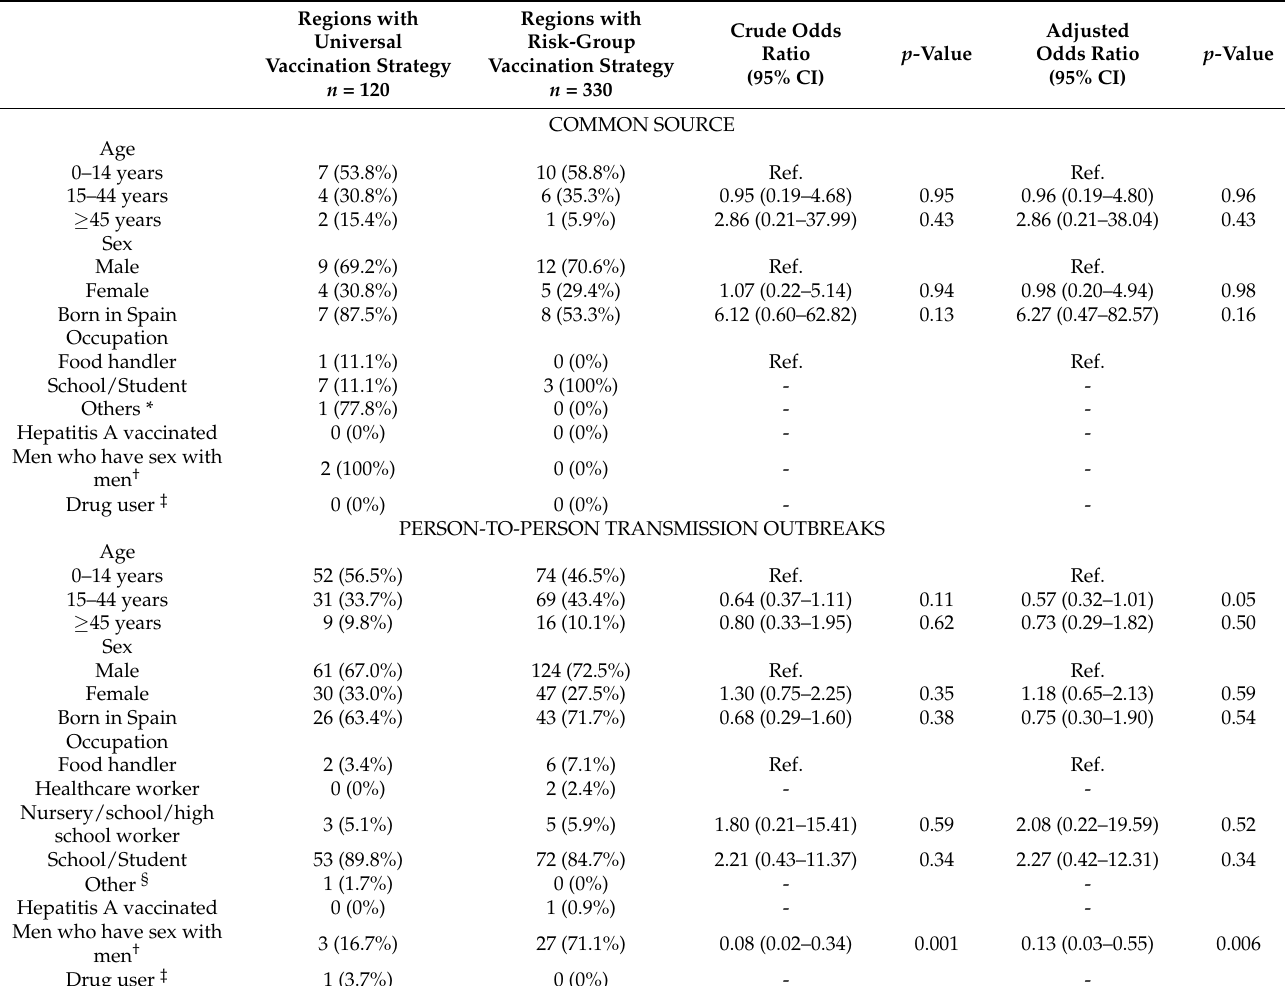
Table 5. Characteristics of the first case in common-source and person-to-person transmission hepatitis A outbreaks in regions with different vaccination strategies. Spain,